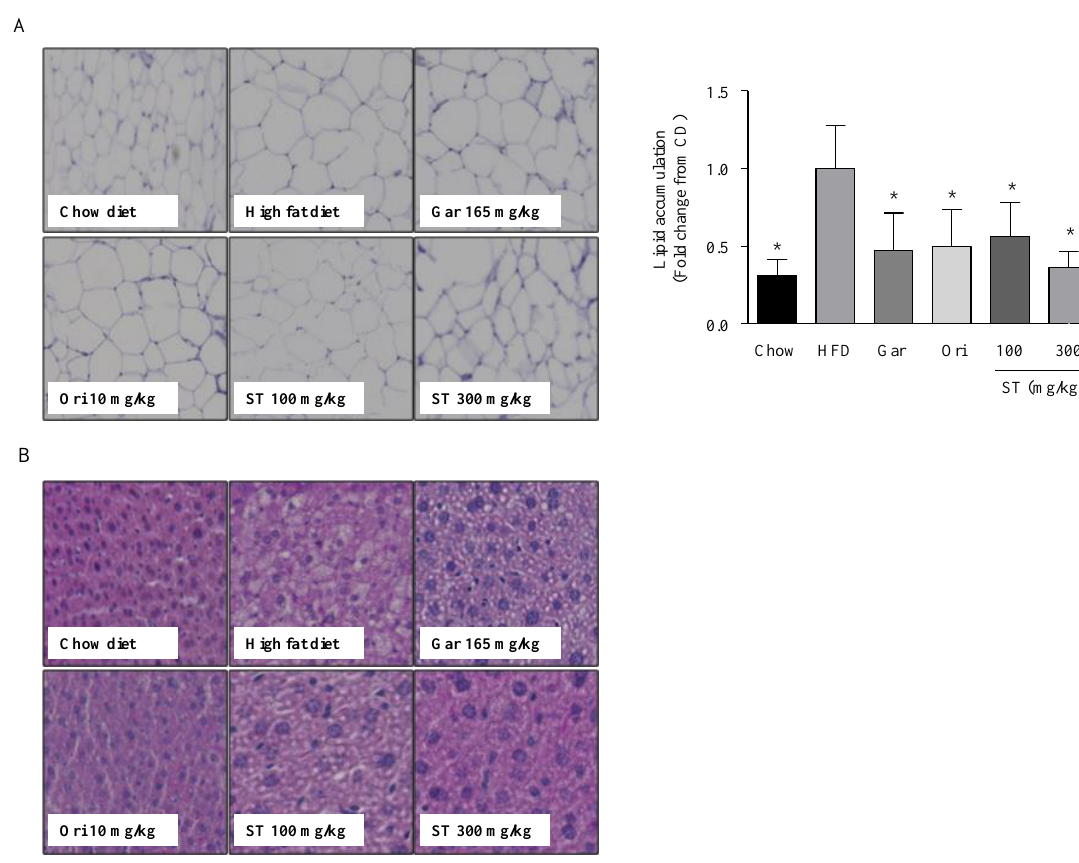
Figure 2. Histopathologic analysis of white adipose and hepatic tissues. ( A ) Histological changes in the central vein and portal area of white adipose tissue as assessed using Image J software. ( B ) Histological changes in the liver. The liver and white adipose tissue sections were stained with hematoxylin and eosin (H&E). Significant differences were identified at * p < 0.05, as compared to the high-fat diet (HDF) group. Gar: Garcinia cambogia ; Gpo: Garcinia cambogia positive control; Ori: Orlistat; ST: Sargassum thunbergii ethanol extract.